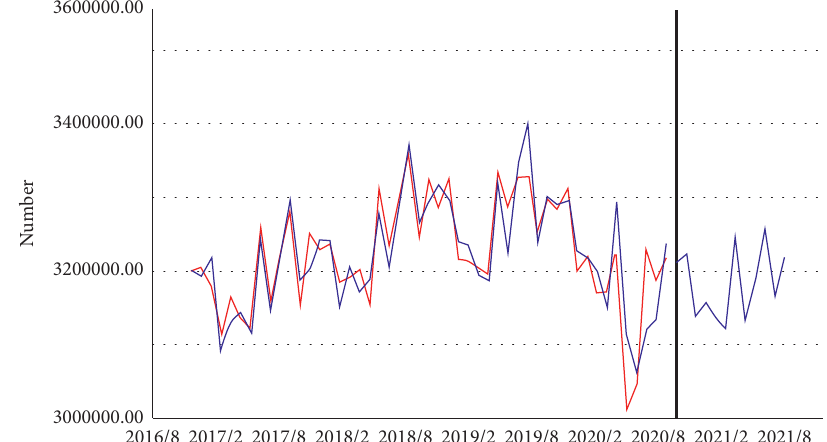
Figure 3: Total value of the time series forecast trend in the United